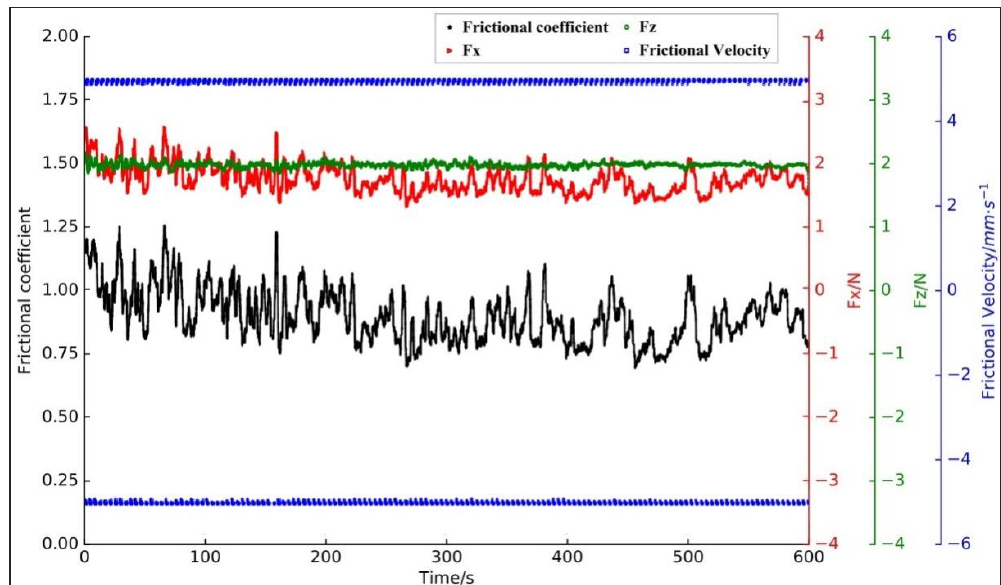
Figure 13. The friction test results after data processing.